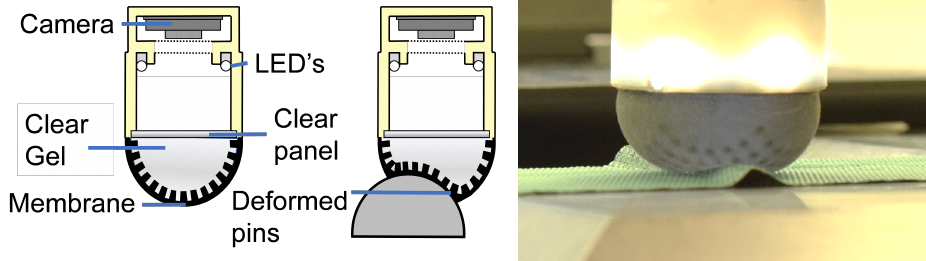
Figure 1: (Left) Schematic of the TacTip construction, (Right) Image of the TacTip tapping down onto a prepreg ply with